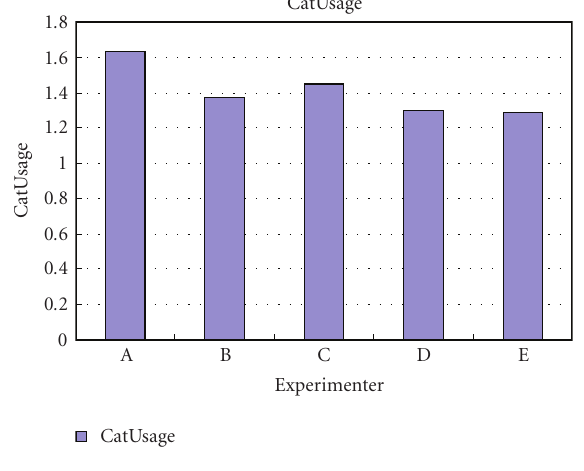
Figure 7: CatUsage of five experimenters.